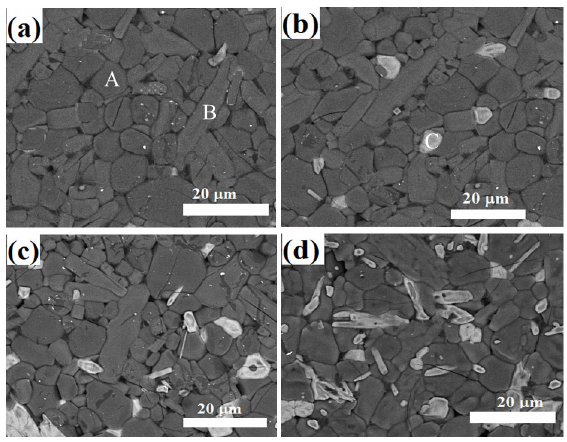
Fig. 2 XRD patterns of (1 − x )Mg 0.95 Ni 0.05 Ti 0.98 Zr 0.02 - O 3 – x Ca 0.6 La 0.8/3 TiO 3 ceramics sintered at 1325 ℃ for 4 h: (a) x = 0, (b) x = 0.05, (c) x = 0.1, (d) x = 0.15.